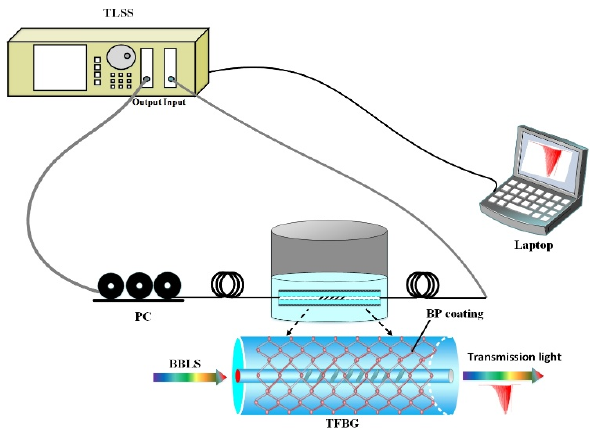
Figure 5. Experimental setup for the RI measurement; the insert shows the detailed structure of the black phosphorus integrated with weakly tilted fiber Bragg grating